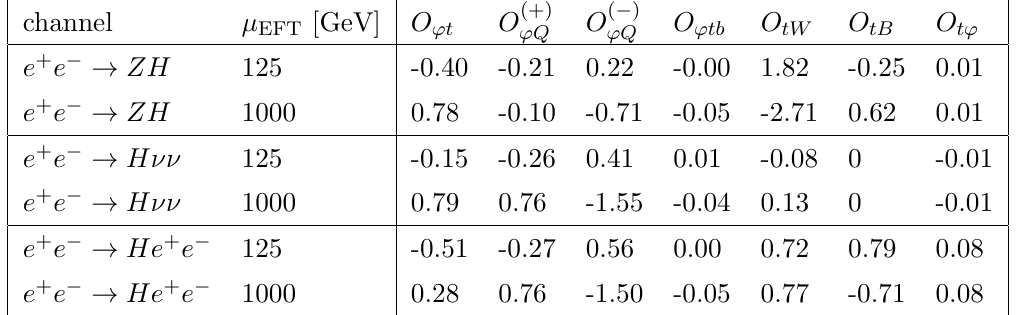
Table 3 . Percentage deviation (cid:22) ij for production channel i and operator j for 250 GeV